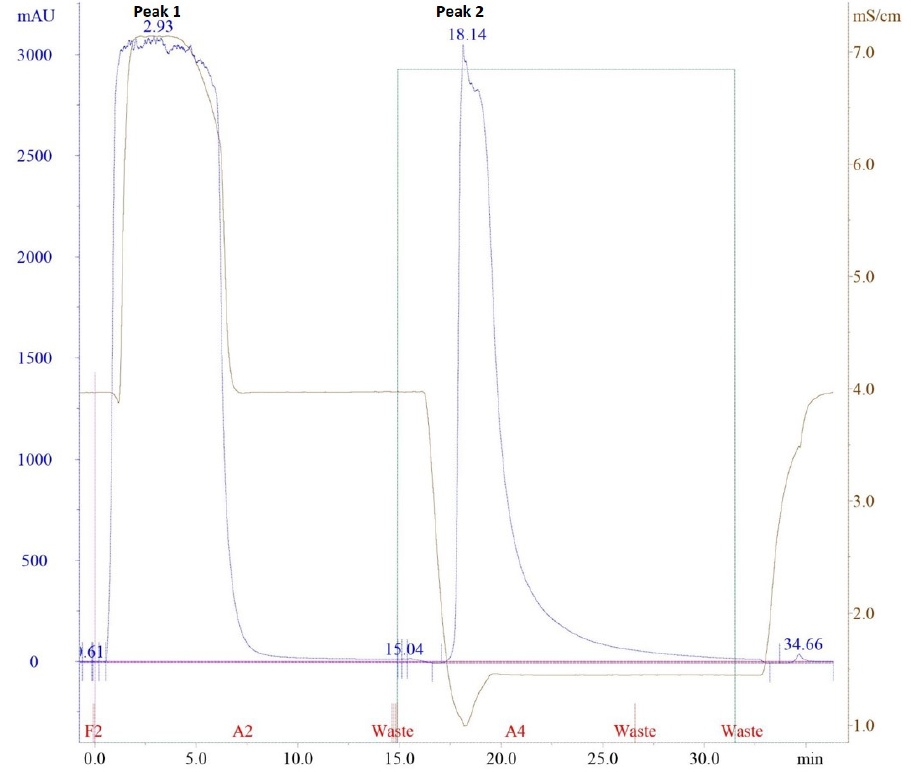
Figure 2. Chromatographic profile by immunoglobulins (IgG) obtained by 20 mM sodium phosphate as the binding bu ff er (Peak 1) and 0.1 M glycine-HCl as the elution bu ff er (Peak 2) identified at 280 nm. as the binding buffer (Peak 1) and 0.1 M glycine-HCl as the elution buffer (Peak 2) identified at 280 Blue line: absorbance (mAU), brown line: conductivity (mS / cm), and green line: concentration of nm. Blue line: absorbance (mAU), brown line: conductivity (mS/cm), and green line: concentration of solvent B solvent B (%).